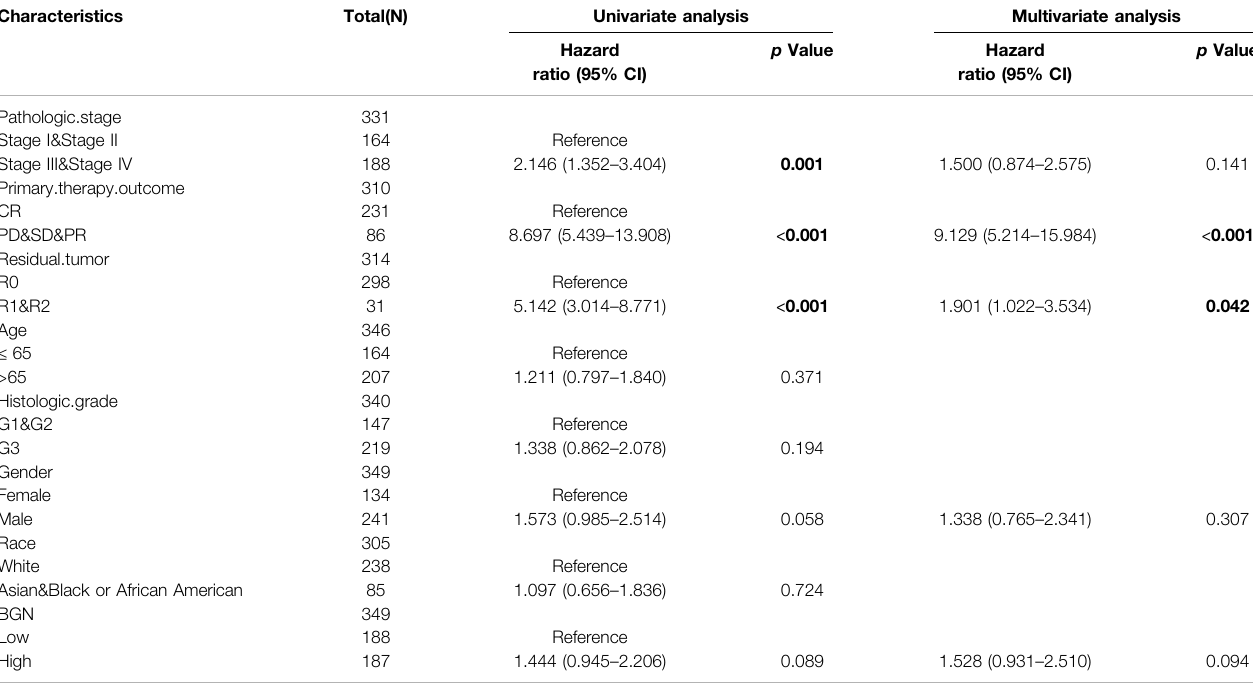
TABLE 9 | Univariate regression and multivariate survival method (Disease Speci fi c Survival) of prognostic covariates in patients with Gastric Cancer Characteristics Total(N)